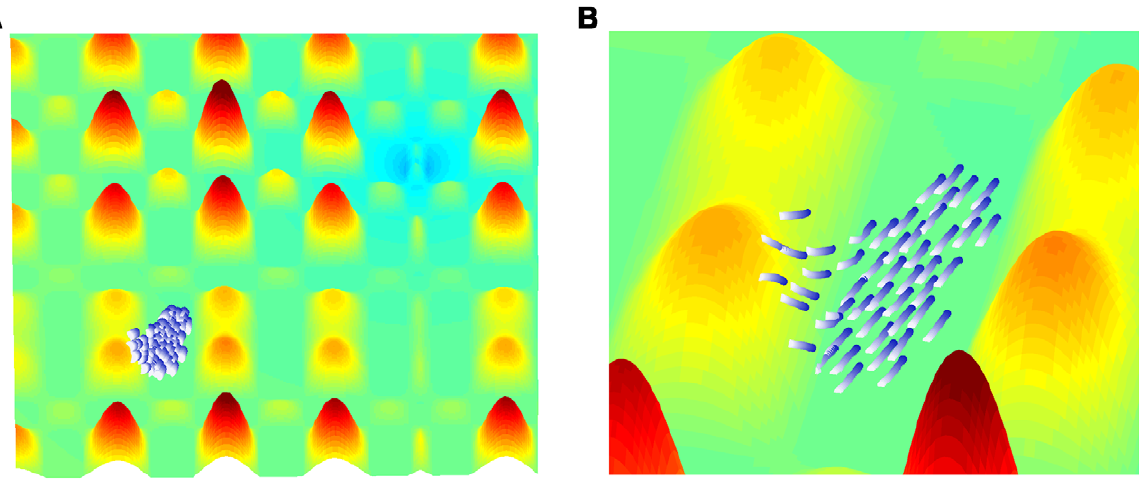
Figure 5. Frames from a simulation of interacting agents moving collectively towards the target. A. Simulation step 200 from starting position. B. Zoom in on the group in the left frame. Simulation parameters are as in Figure 4, w ~ 0 : 5